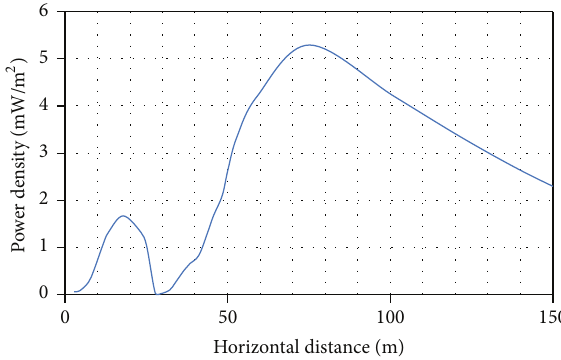
[18]. The main lobe of 𝐹(𝜃) can be approximated by cos 𝑞 (𝜃 − 𝛼)